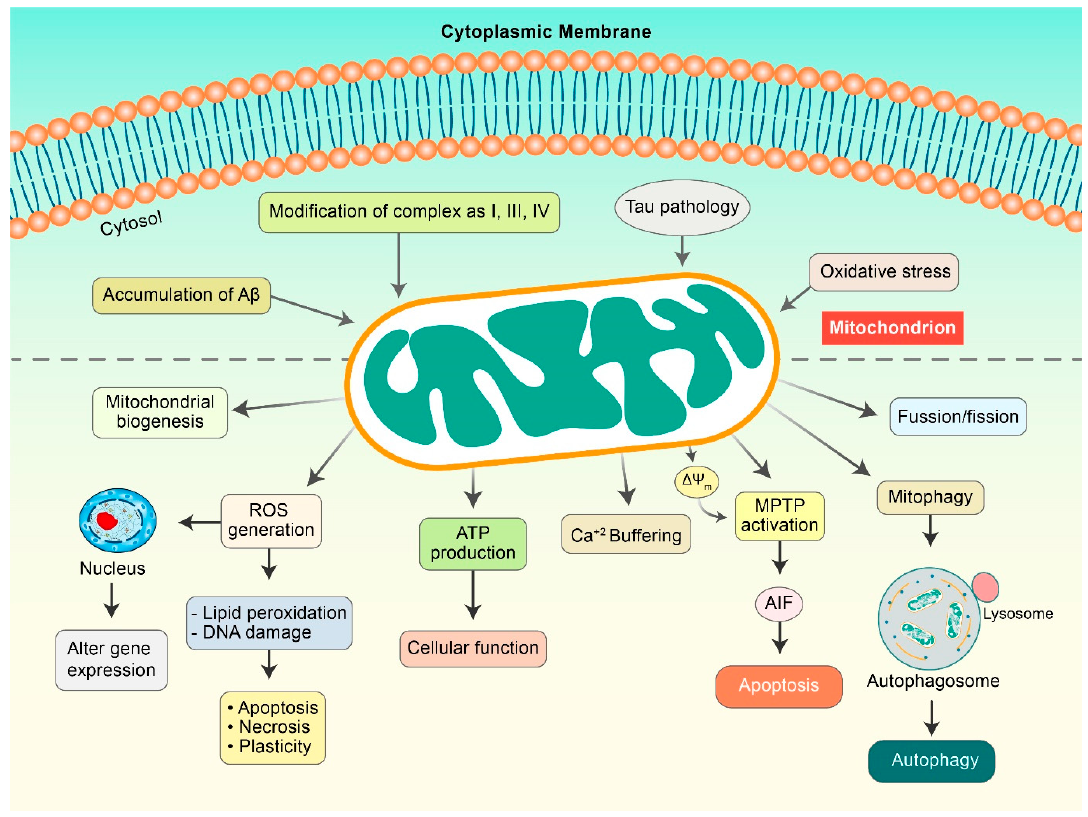
Figure 2. Mitochondrial dysfunction in AD pathogenesis. A β and Tau initiate mitochondrial dysfunctions that can result in the modulation of several factors. ROS is generated, which causes lipid peroxidation and DNA damage to initiate apoptosis. Damaged mitochondria demonstrate a decrease in mitochondrial membrane potential ( ΔΨ m) as a result of the activation of mitochondrial permeability transition pores (mPTPs), which release cytochrome c and apoptosis-inducing factor (AIF), and consequently, initiate apoptosis pathway. A β and pTau improve mitochondrial fission and mitophagy.